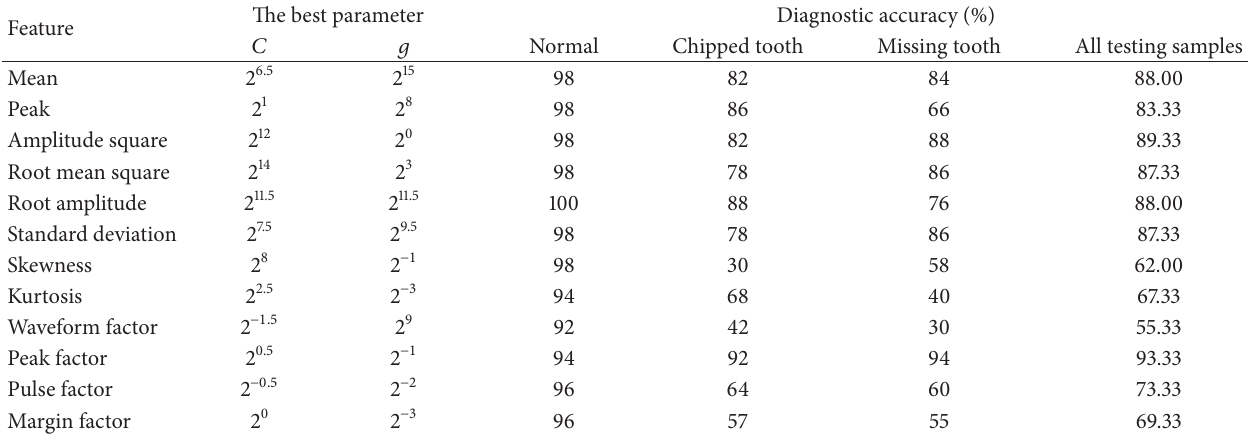
Table 2: Diagnostic results of gear by using different features for fusion.